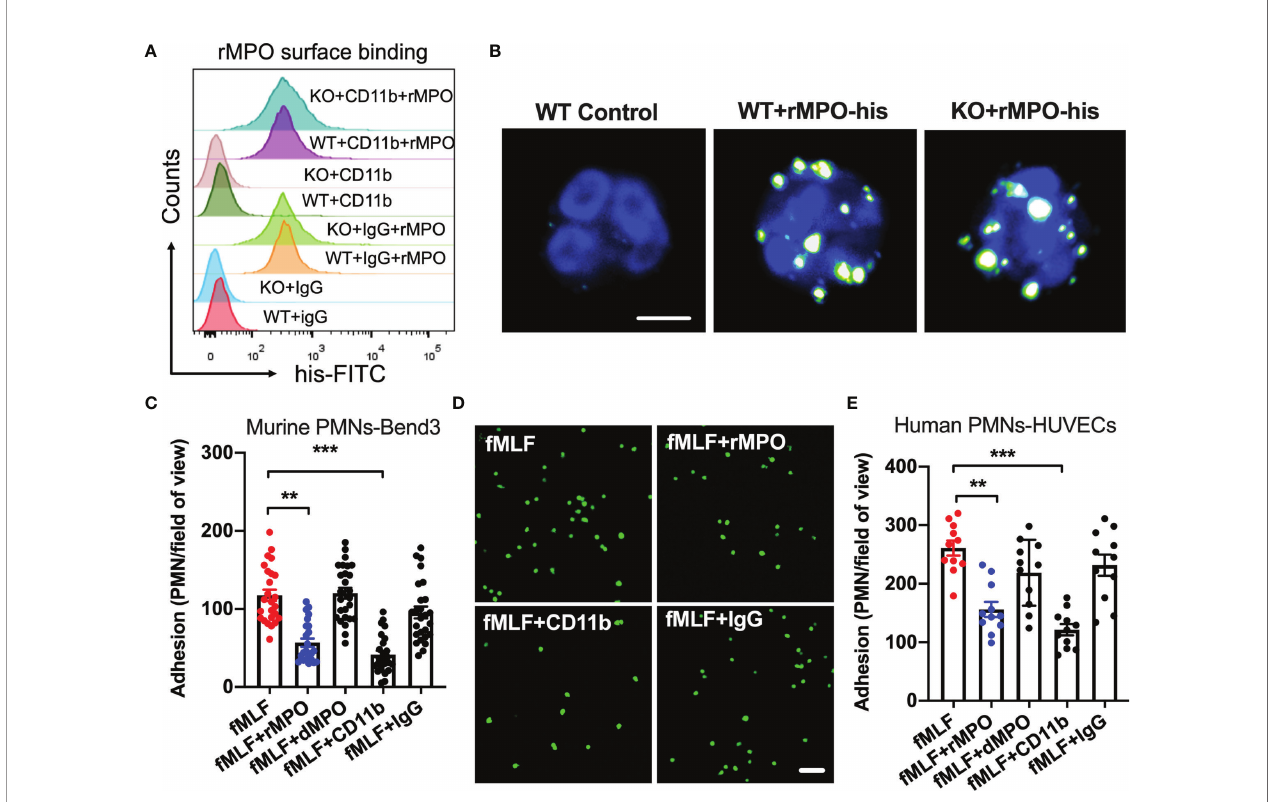
FIGURE 6 | Free MPO attenuates PMN adhesion to in fl amed endothelium. (A) To assess MPO binding to the PMN surface and whether it is CD11b dependent, BM-PMNs were incubated with His-tagged recombinant MPO (rMPO, 10µg/ml 30min) in the presence of fMLF (500nM, to induce CD11b expression and activation) and with/without the addition of control IgG and anti-CD11b inhibitory Abs. MPO binding analyses were examined by fl ow cytometry on non-permeabilized PMNs and detection of His-tag. Robust MPO-His binding to PMNs was seen, however this was independent of CD11b expression. Representative of N=5 independent repeats. (B) The binding of His-tagged recombinant MPO to WT and MPO KO BM-PMNs was further con fi rmed by immuno fl uorescence. Surface-bound MPO was detected by anti-His antibody staining. The bar is 5µm. (C, D) To establish whether MPO impairs PMN adhesion, BM-PMNs were fl uorescently stained (CellTracker Green) and incubated with TNF a -stimulated (50ng, 24hr) Bend3 ECs in the presence of fMLF stimulation (500nM) and with/without the addition of intact or control denatured (by boiling) rMPO. (C) Quanti fi cation and (D) Representative images reveal decreased adhesion in the presence of rMPO and CD11b inhibitory Ab but not the IgG control or denatured rMPO protein. The bar is 50µm. N=5 independent repeats in duplicates with at 3-5 randomly selected fi elds analyzed per condition. (E) Similar adhesion assays were performed using freshly isolated human PMNs and HUVECs, revealing consistent inhibition of PMN adhesion by rMPO. N=3 independent repeats in triplicates. **p < 0.01, ***p <